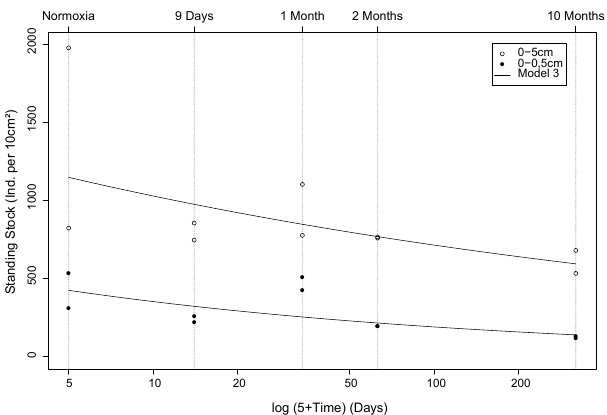
Fig. 2. Foraminiferal standing stocks plotted against deployment time. Open circles represent standing stock in the 0–5cm depth interval, filled black circles correspond to the standing stock in 0–0.5cm depth. Solid black lines represent the modeled stand- ing stocks plotted against time, for the two depth intervals, after Model 3. Note that incubation time is represented on a transformed log scale (5 +